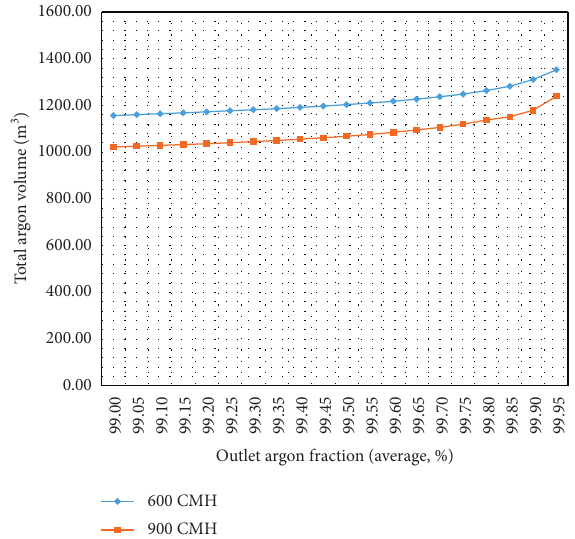
Figure 15: Total argon volume to achieve the outlet argon fraction